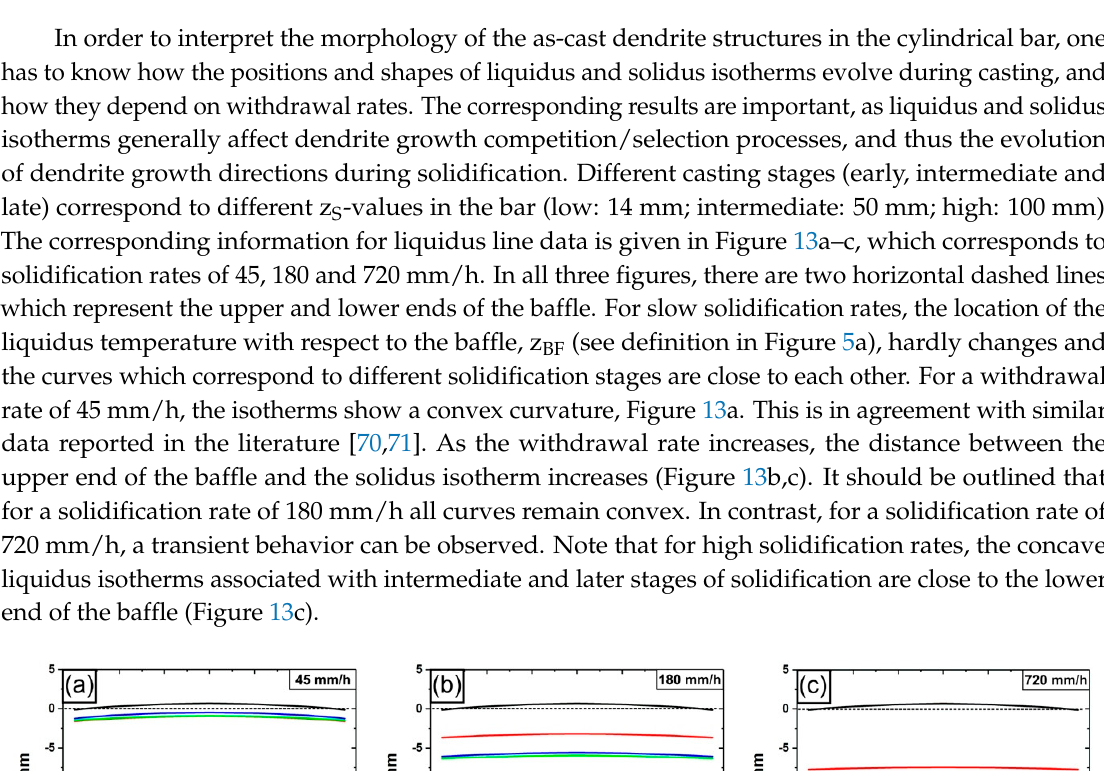
Figure 13. Effect of withdrawal rates on the evolution of liquidus isotherm curvatures and positions during Bridgman processing. Different casting stages (early, intermediate and late) correspond to different z S -values in the bar (low: 14 mm; intermediate: 50 mm; high: 100 mm). ( a ) v = 45 mm/h, ( b ) v = 180 mm/h ( c ) v = 720 mm/h. For details see text.